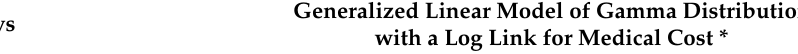
Table 3. Accumulative intensive care unit stay during index hospitalization and medical cost stratified by aneurysm repair modalities in propensity score–matched patients with ruptured cerebral aneurysms who received surgical clipping or endovascular